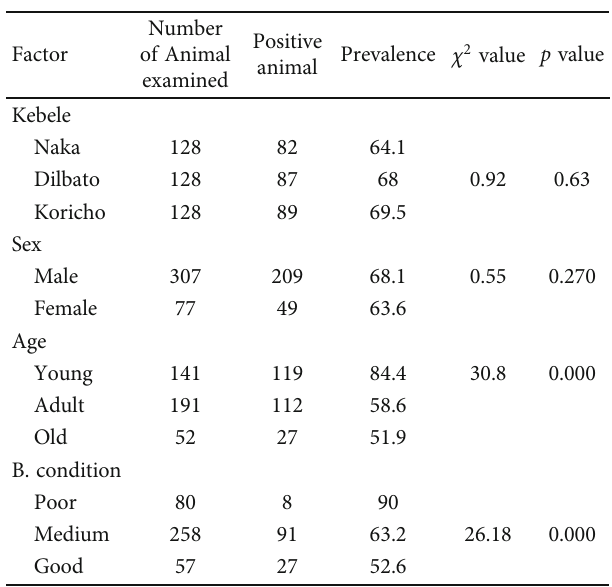
Table 2: Association analysis of